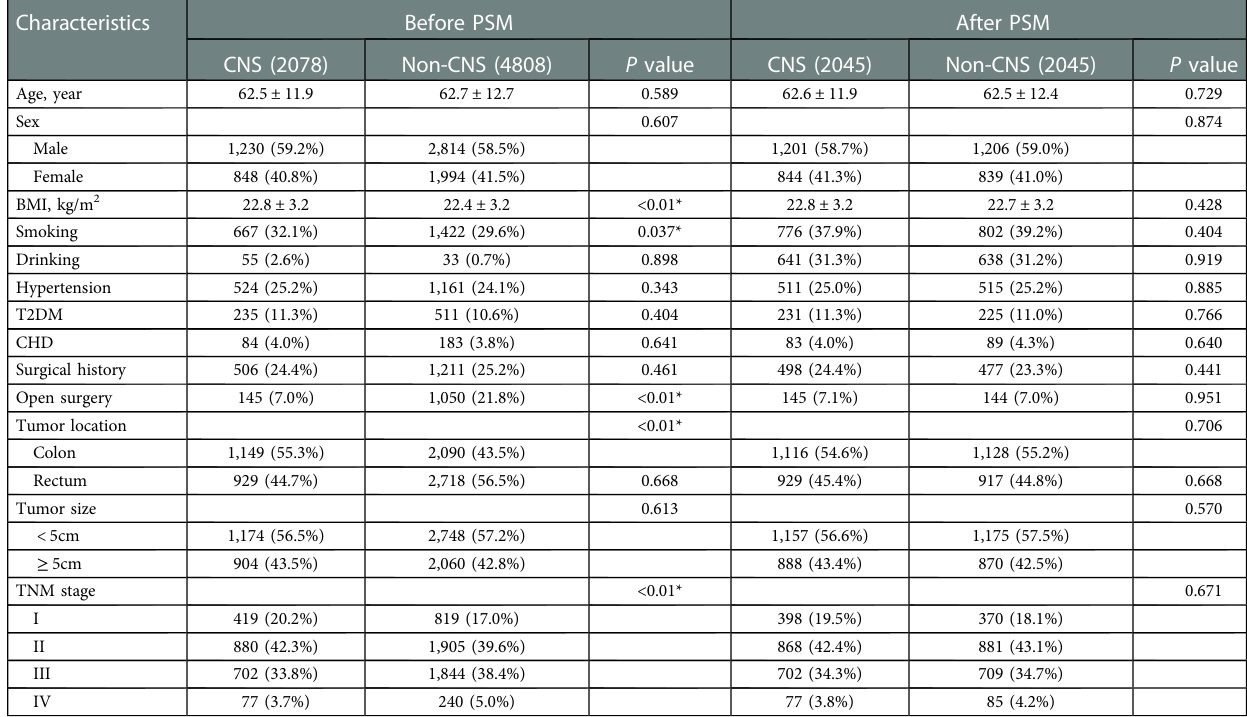
TABLE 2 Baseline characteristics before and after PSM.